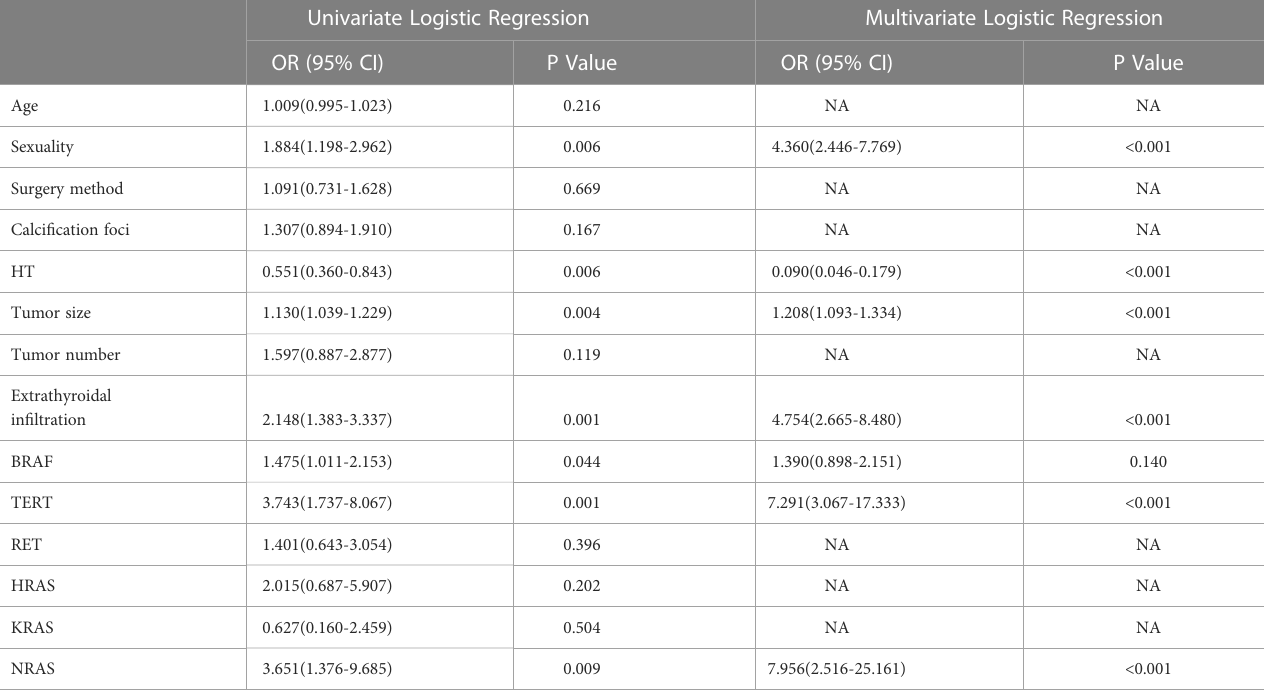
TABLE 2 Univariate and multivariate analysis of CLNM in the training cohort. Univariate Logistic Regression